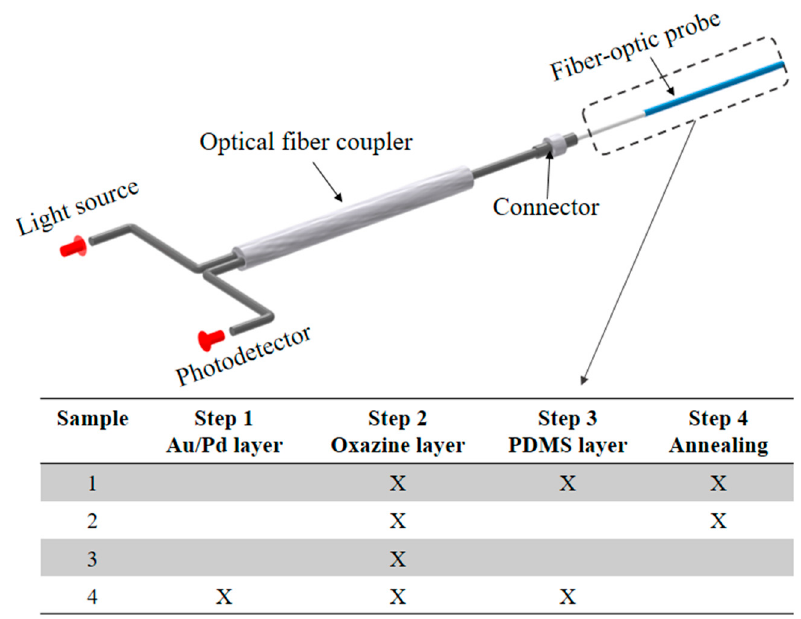
Figure 3. Experimental setup for the sensor’s response acquisition. The description of which steps were followed for each set of samples is also shown.